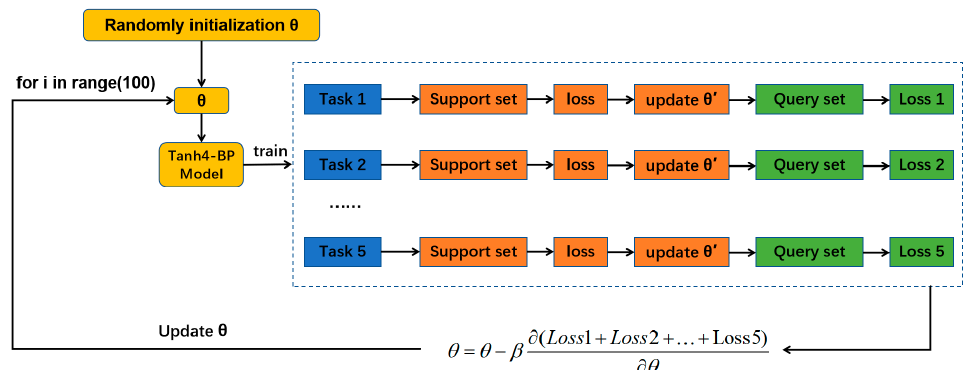
Figure 11. Tanh4-BP-MAML model parameter update.